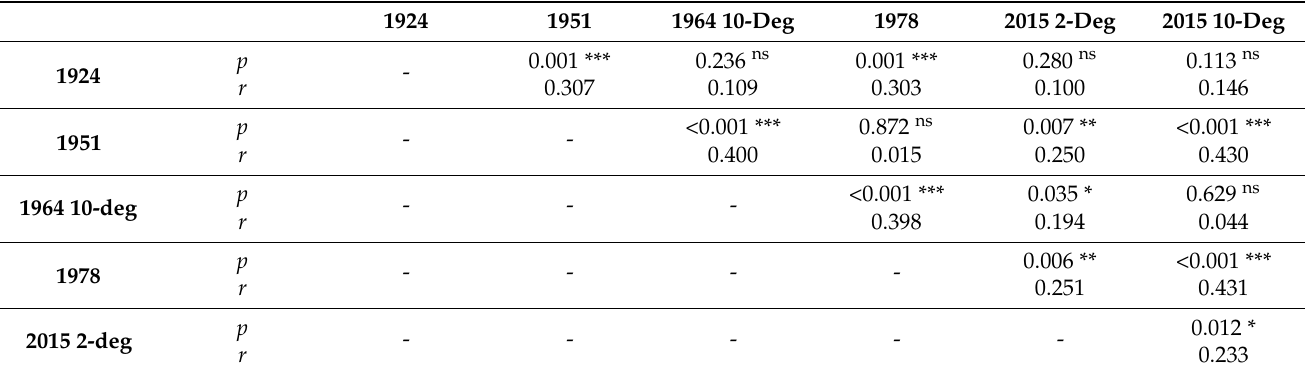
Table 4. Rank sum test and effect size for CIE 1931 y ( p -value and effect size ( r )).